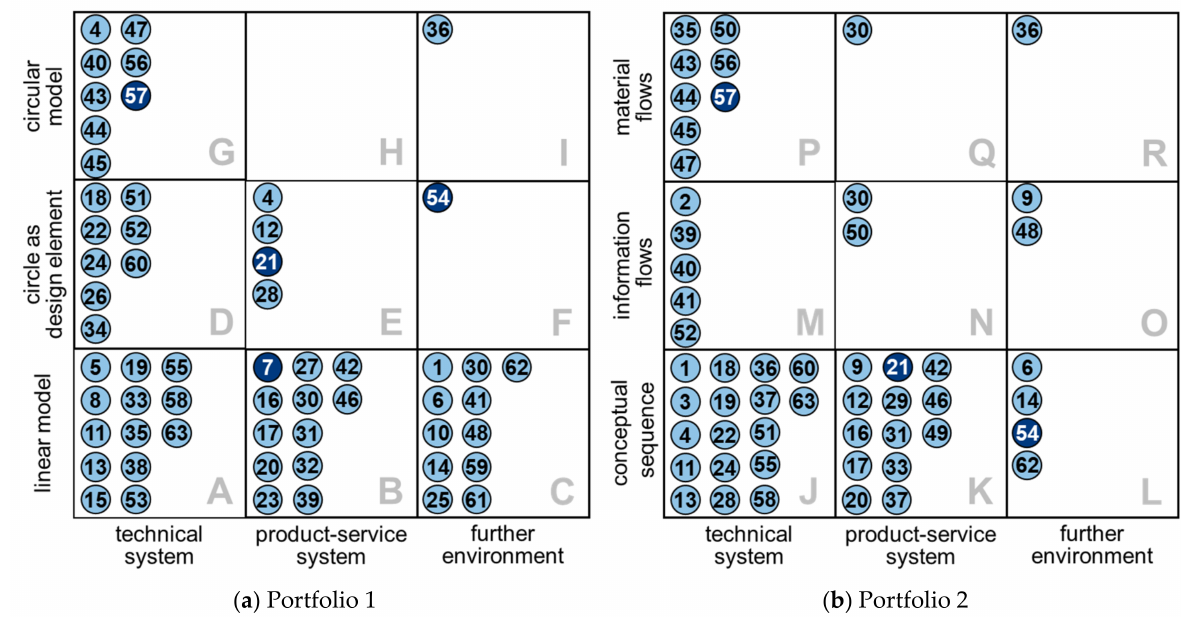
Figure 5. Lifecycle portfolios focusing on technical systems, product–service systems and further environment with regard to product classes (light blue dots) and including instances (dark blue dots): ( a ) categorization differentiating linear and circular models; ( b ) categorization differentiating purely conceptual sequence models and models with specific focus on either information or material